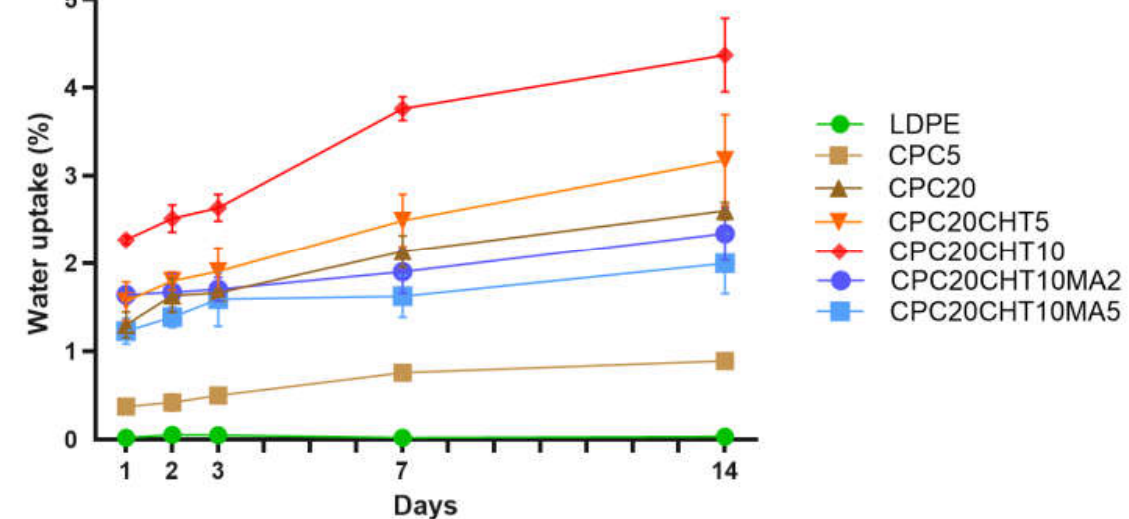
Figure 5. The water uptake behavior of the pristine LDPE and its cork biocomposites.